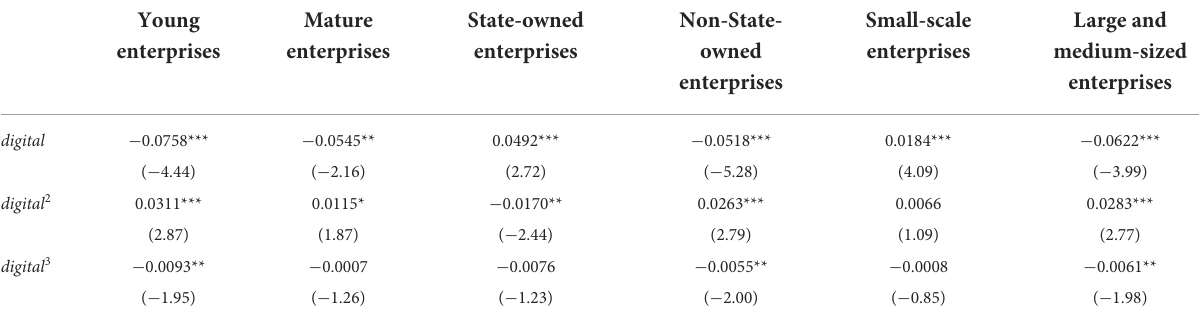
TABLE 4 Analysis of